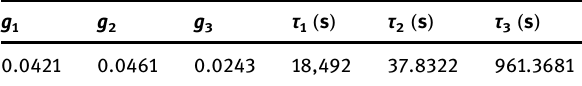
Table 2: Fitted coe ffi cients of the Prony